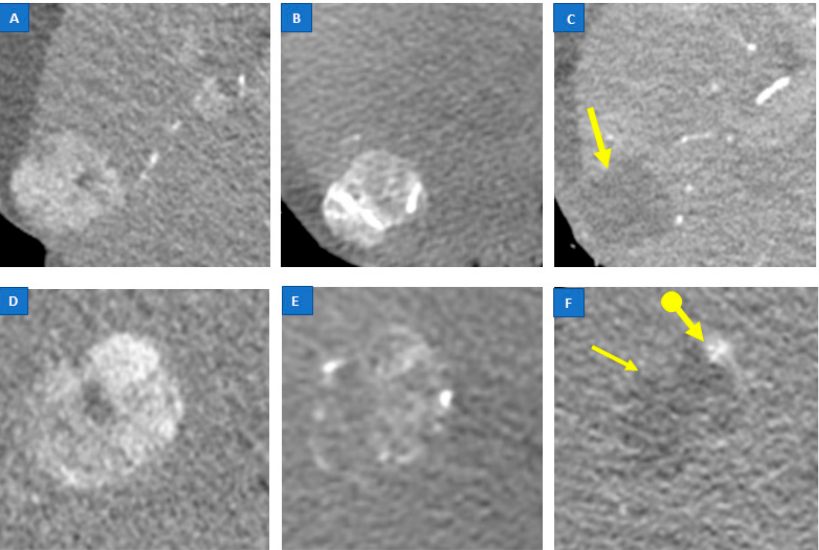
Figure 3. Lesion with complete response ( A – C ): pre-procedural CT arterial phase ( A ); unenhanced post-procedural cone-beam CT ( B ) (intensity score 2, homogeneity score 0, margin evaluation score 1); 1-month follow up CT arterial phase ( C ) showing hypodense area due to treatment without pathological viable tissue ( arrow ). Lesion with partial response ( D – F ): pre-procedural CT arterial phase ( D ); unenhanced post-procedural cone beam CT ( E ) (intensity score 2, homogeneity score 1, margin evaluation score 0); 1-month follow-up CT arterial phase ( F ) showing hypodense area due to treatment ( arrow ) with persistence of pathological viable tissue characterized by intense enhancement ( dot and arrow